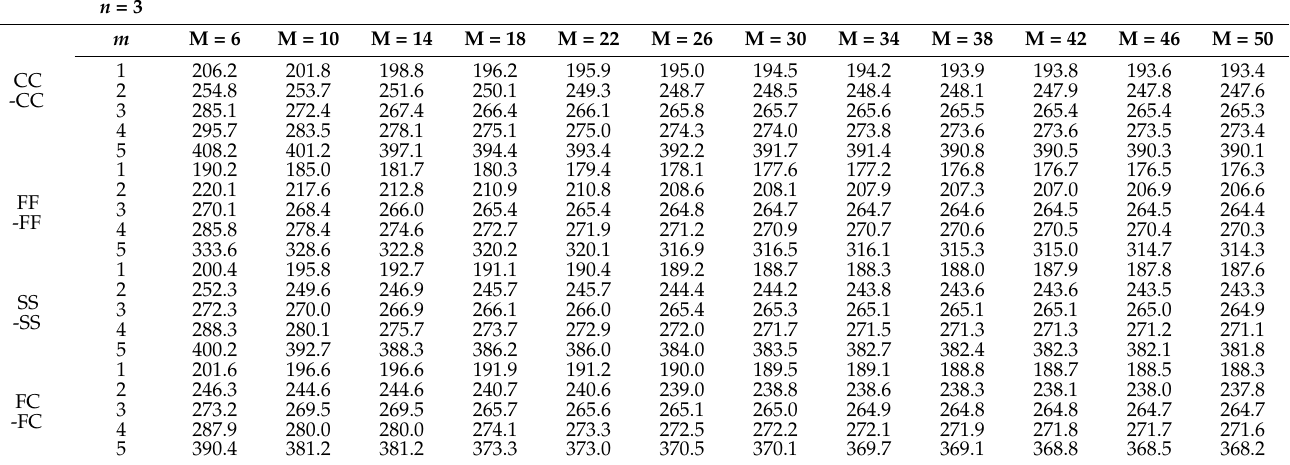
Table 1. The lowest five frequency parameters of an LCDCSS with various truncation values.